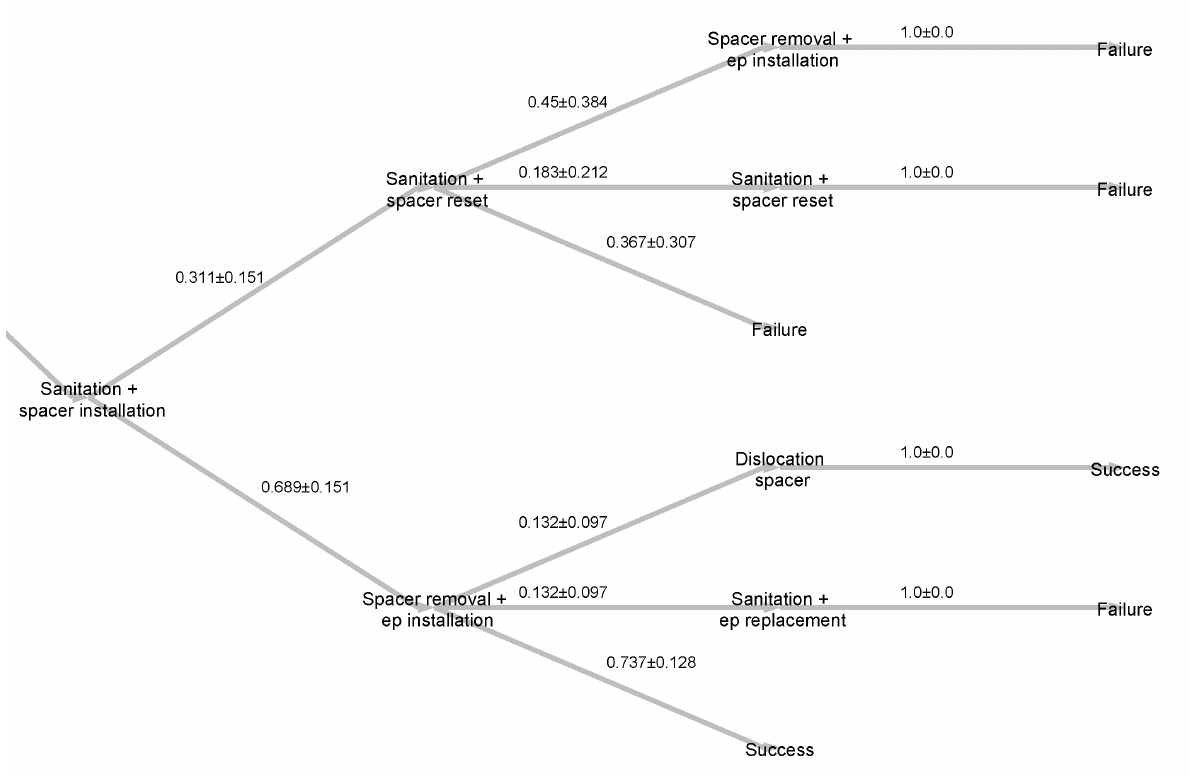
Figure 1. A fragment of the decision tree partial re-THR with confidence intervals for transition